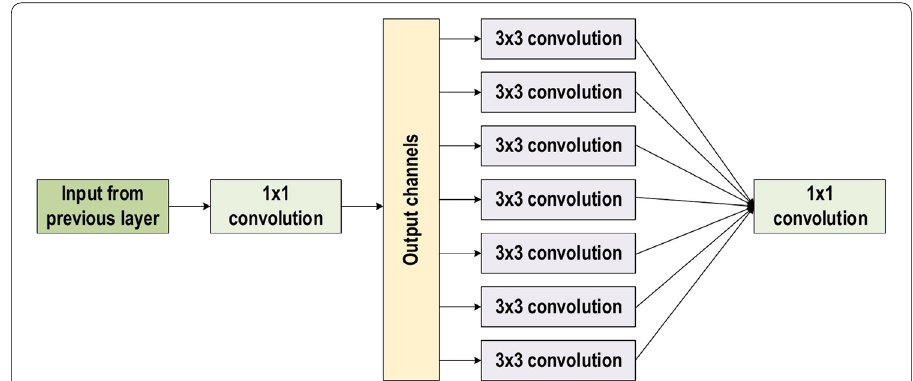
Fig. 24 The basic block diagram for the Xception block